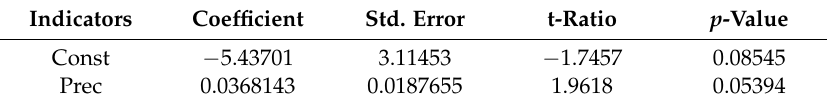
Table 4. Pooled OLS, using 69 observations, Included 3 cross-sectional